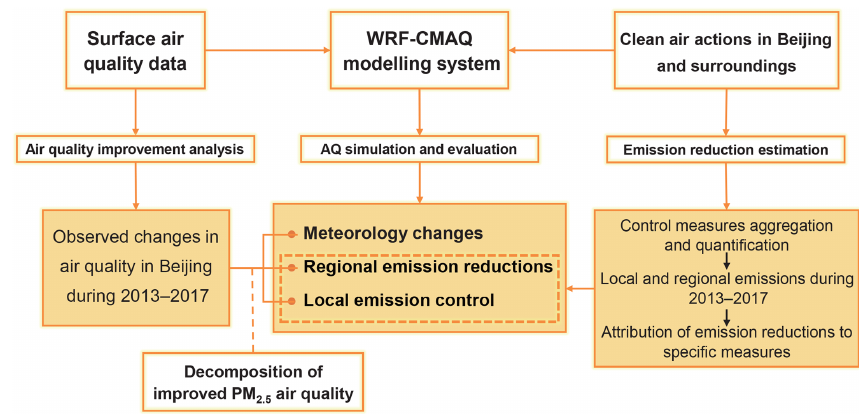
Figure 1. Methodological framework for the decomposition analysis of improved PM 2 . 5 -related air quality in Beijing during 2013–2017.